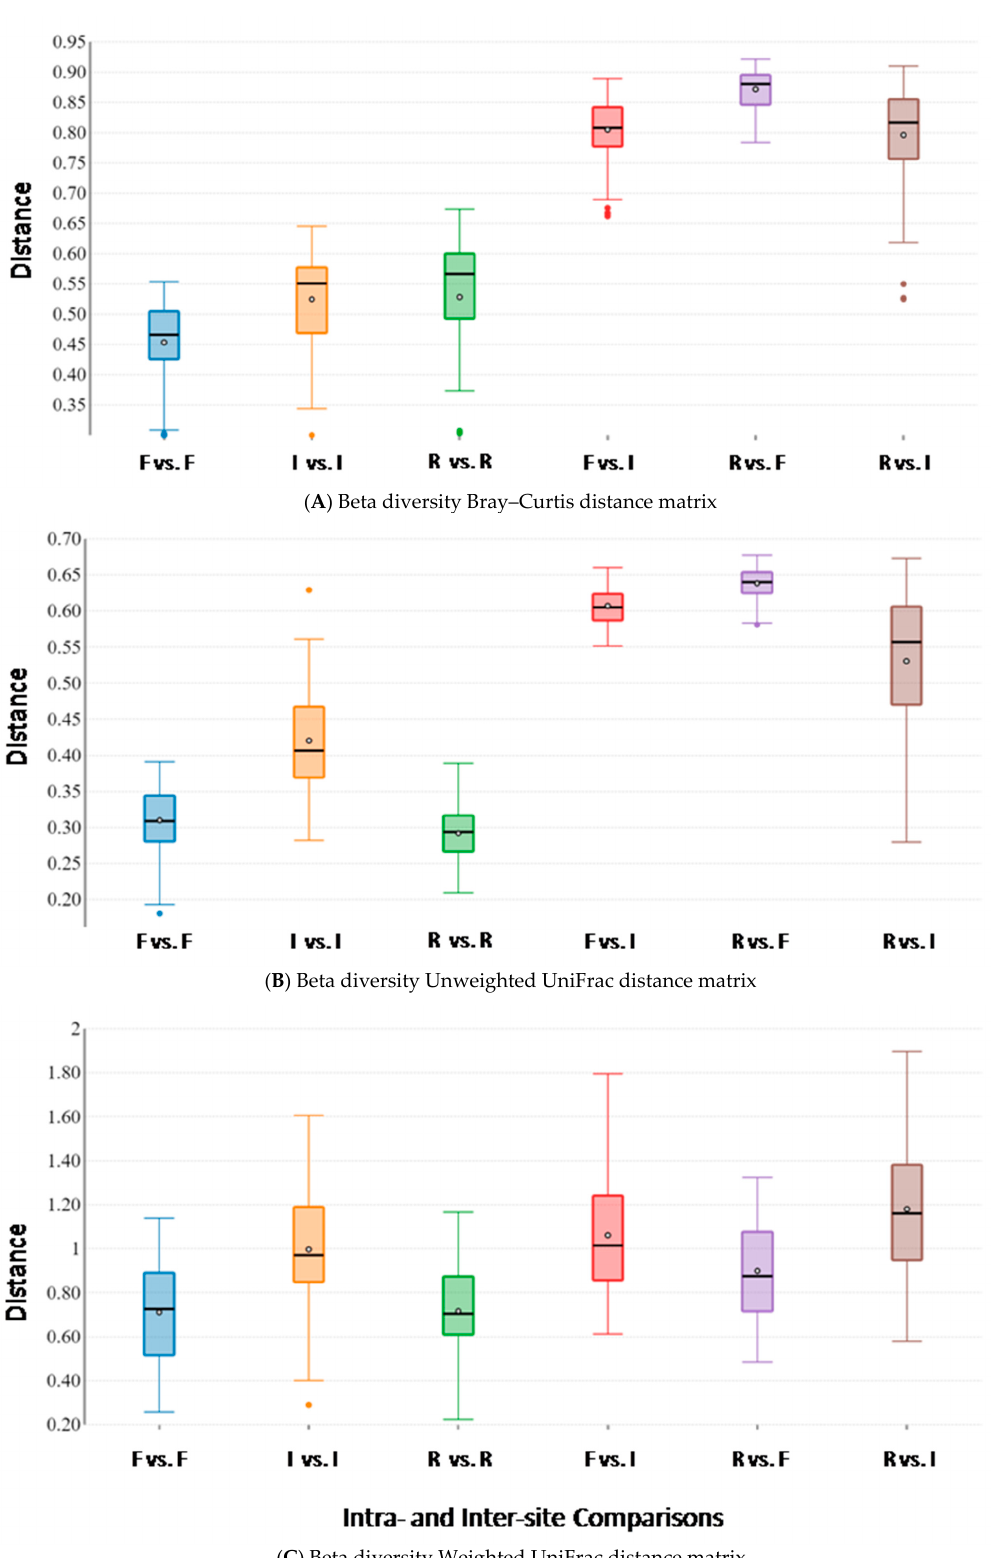
Figure 4. Beta diversity box plots within and between body sites from traditionally fed water buffaloes ( n = 10). Distances calculated with different matrices: ( A ) Bray–Curtis, ( B ) Unweighted UniFrac and ( C ) Weighted UniFrac. The letter F indicates feces, I indicates large intestine, R indicates rumen.